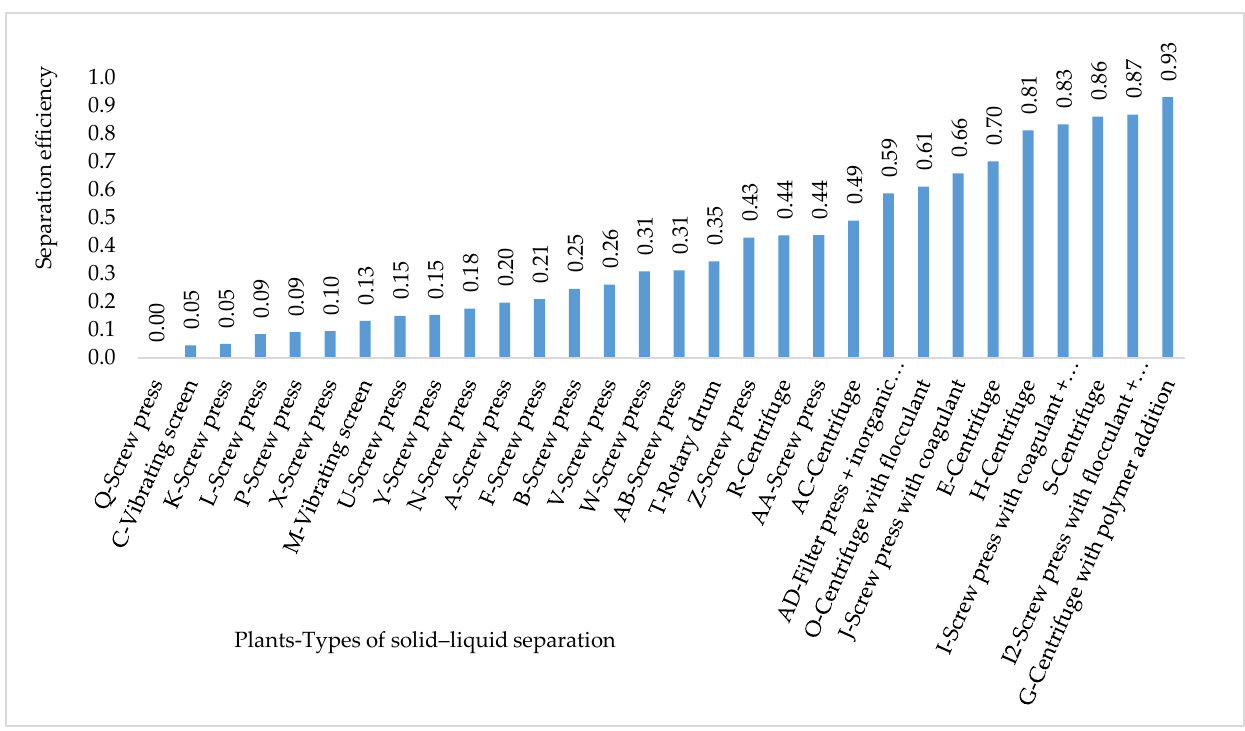
Figure 2. Separation efficiency vs. types of solid – liquid separators used for plants.